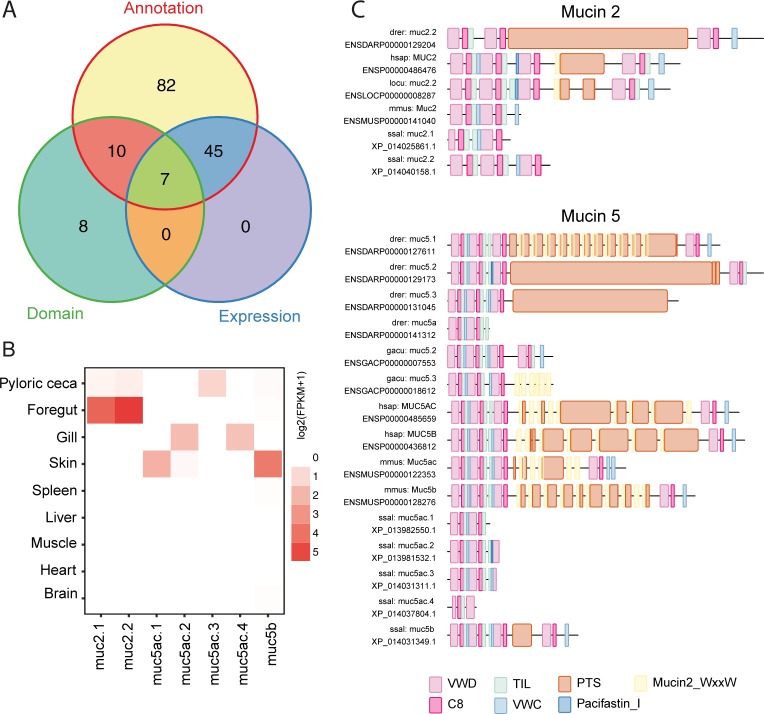
Identification of seven putative mucin genes, with annotation, transcription (public RNAseq data) and protein architecture.A According to RefSeq annotation, 144 genes were annotated as mucins, out of these 52 of were considered to be transcribed, whereas 25 genes had a minimum domain structure of VWD-C8-TIL. Seven mucin genes were found using the combination of these three approaches. B Protein architecture of the seven putative Atlantic salmon (Salmo salar, ssal), mucin genes. For comparison, the protein architecture of Muc2 and Muc5 from stickleback (Gasterosteus aculeatus, gacu), zebrafish (Danio rerio, drer), mouse (Mus musculus, mmouse), human (Homo sapiens, hsap) is also presented in the figure. C Transcription of the seven putative mucin genes in the tissues; Pyloric ceca, foregut, skin, pancreas, gill, spleen, liver, muscle heart and brain. The data is based on a public RNA-Seq data set. FPKM values as indicated in the figure.